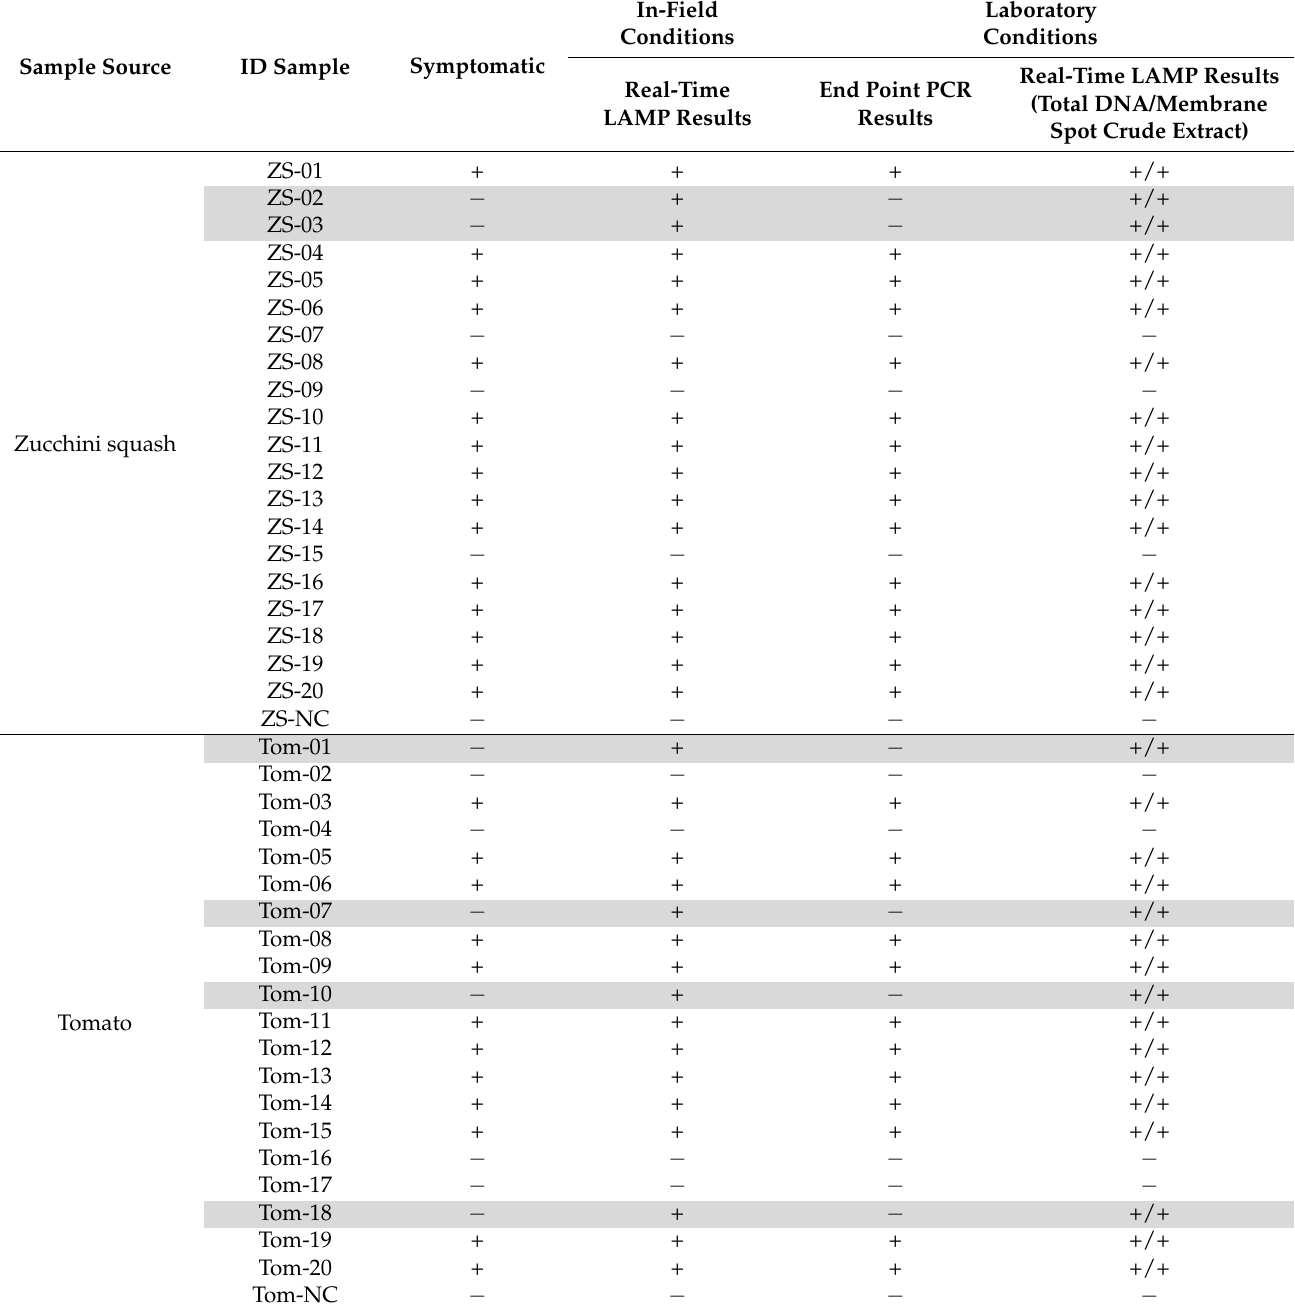
Table 6. Results of in-field real time LAMP detection of ToLCNDV using the rapid sample preparation method of symptomatic and asymptomatic field samples (zucchini squash, tomato, and pepper) and comparison to end-point PCR and real-time LAMP (using both total DNA and membrane spot crude extract) in laboratory conditions. Asymptomatic samples detected by real-time LAMP assay are underlined in